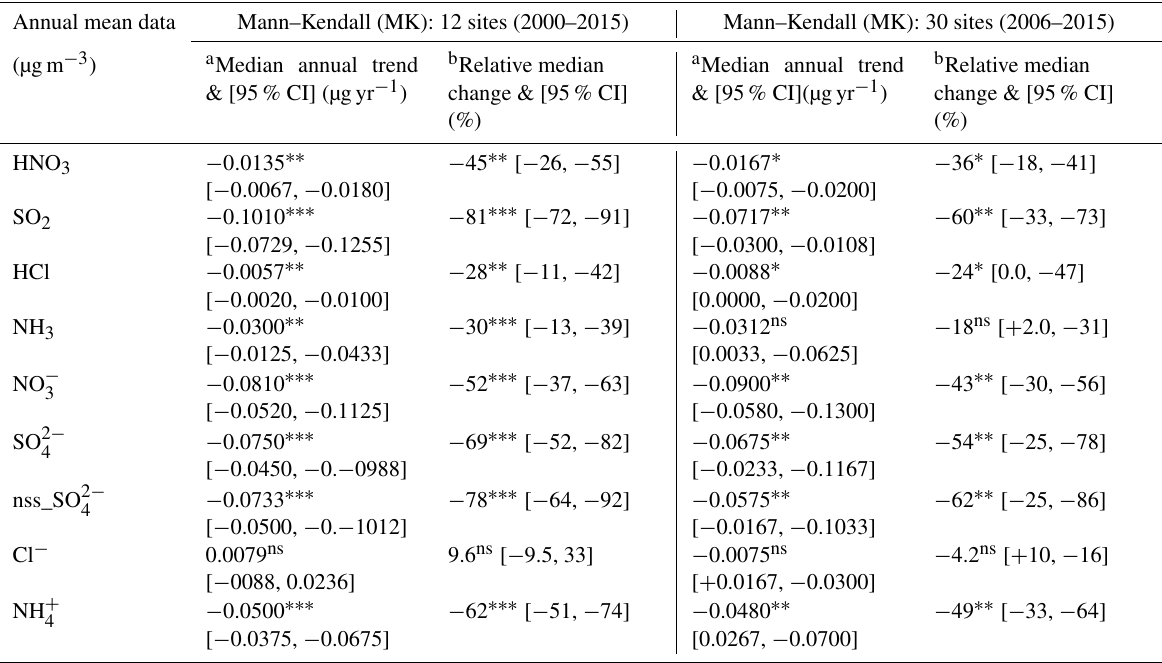
Figure 13. Long-term trends in (a) acid gases and (b) aerosol concentrations (µgmoleculem − 3 ) from the UK Acid Gases and Aerosol Network (AGANet). Each data point represents the annually averaged measurements from either the original 12 AGANet sites for the 16- year period from 2000 to 2015 or the expanded 30 AGANet sites for the 10-year period from 2006 to 2015. NH 3 and particulate NH + 4 measured at the same time in the UK National Ammonia Monitoring Network (NAMN, Tang et al., 2018) are also included for comparison. Table 4. Summary of Mann–Kendall (MK) time series trend analysis on annually averaged gas and aerosol concentrations from the UK Acid Gases and Aerosol Monitoring Network (AGANet) for (i) 12 sites that were operational over the period 2000 to 2015 and (ii) 30 sites that were operational over the period 2006 to 2015. NH 3 and NH + concentrations data measured at the same time from the UK National 4 Ammonia Monitoring Network (NAMN, Tang et al., 2018) are also included for comparison. The 95% confidence interval (CI) for the median trend and relative median change (%) are also